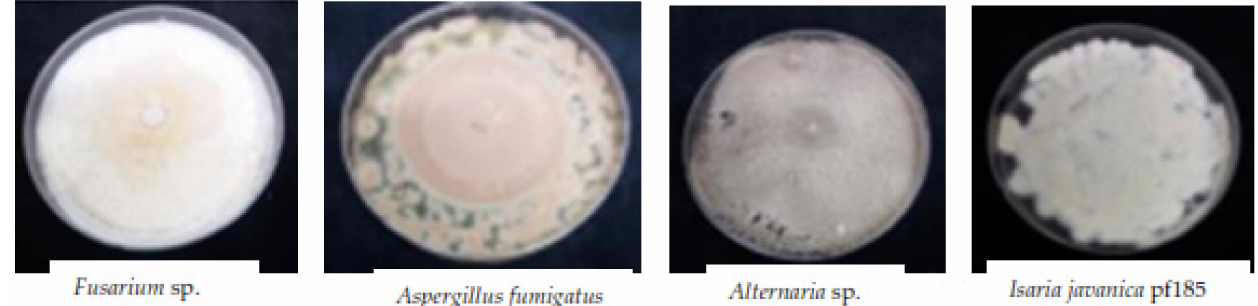
Figure 6. Some taxonomic groups isolated from leaf tissue of fungus-treated